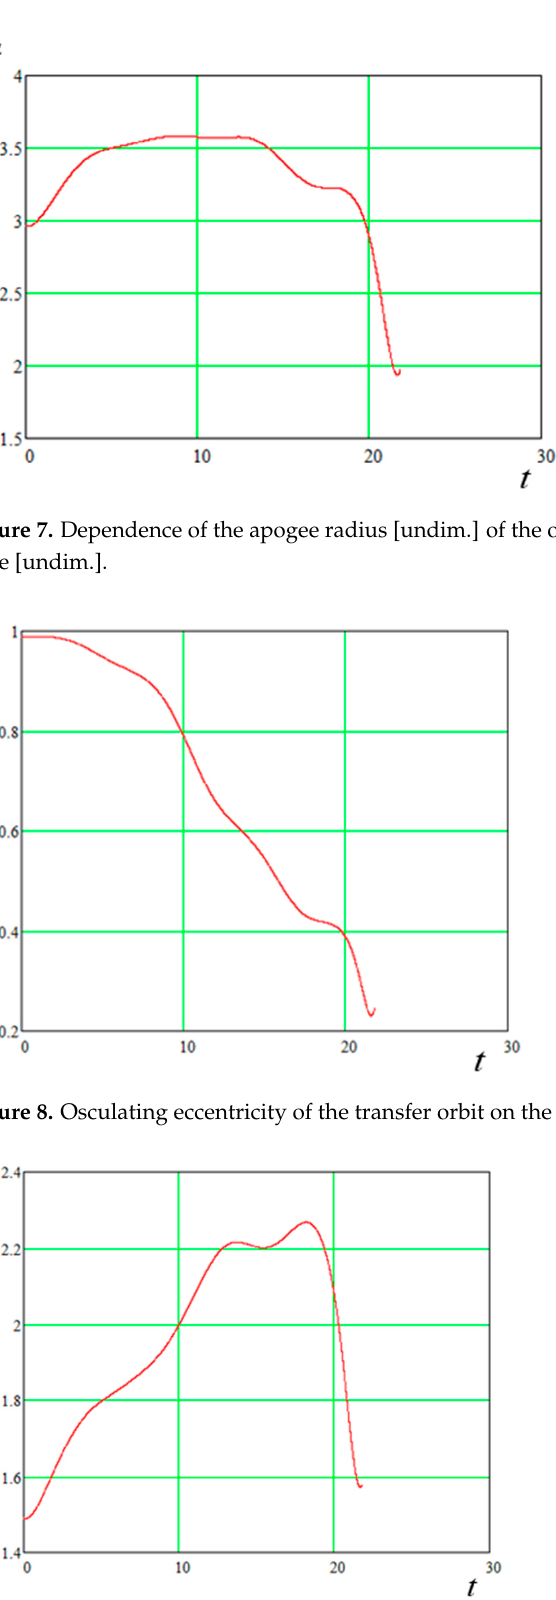
Figure 8. Osculating eccentricity of the transfer orbit on the flight time [undim.]. Figure 9. Osculating semi-major axis [undim.] of a transfer orbit on the flight time [undim.].